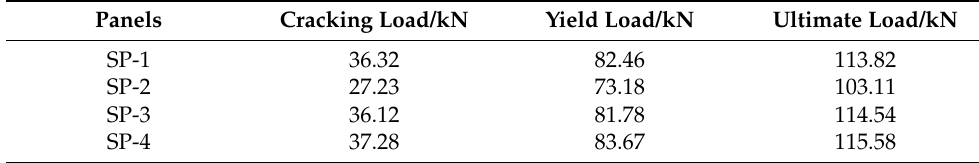
Table 3. Test results of each specimen.